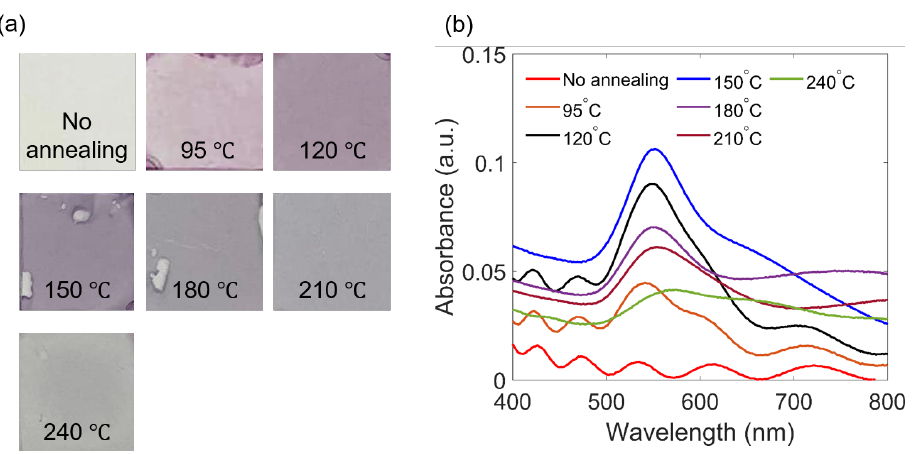
Figure 4. The temperature dependence on the formation of Au NPs: ( a ) Direct smartphone pictures of the nanocomposite samples of SU-8 mixed with 1 wt.% Au salt, obtained by thermal treatment at different temperatures. ( b ) The corresponding SPR